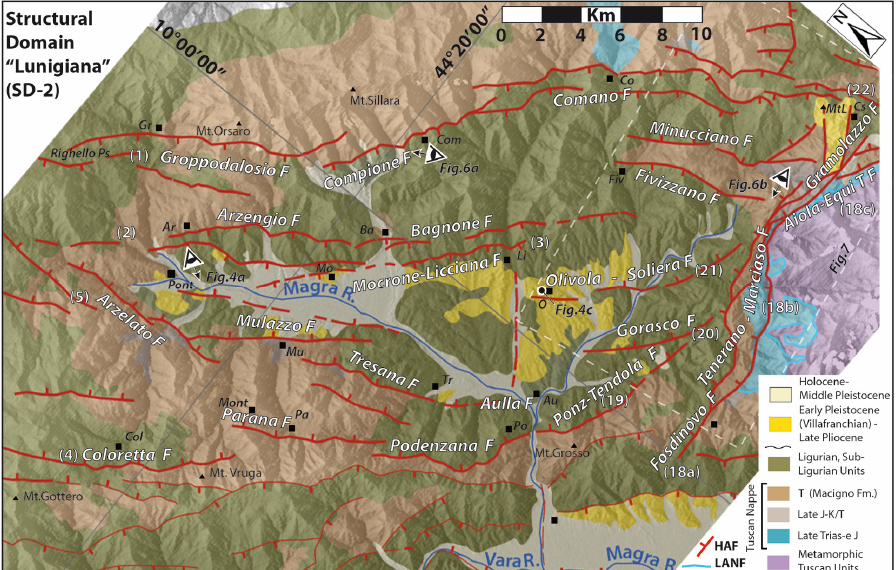
Figure 3. Main fault systems and geology in structural domain SD2 (Lunigiana). The map is derived from [57–60] and our work. Fault identification numbers are as reported in Table S1. HAF: steep normal faults (thicker lines for those described); LANF: low-angle detachment faults; Ar: Arzengio; Au: Aulla; Ba: Bagnone; Co: Comano; Col: Coloretta; Com: Compione; Cs: Castagnola; Fiv. Fivizzano; Gr: Groppodalosio; Li: Licciana; Mont: Montereggio; MtL: Mt. Lupacino; O: Olivola; Pa: Parana; Po: Podenzana; Pont: Pontremoli.